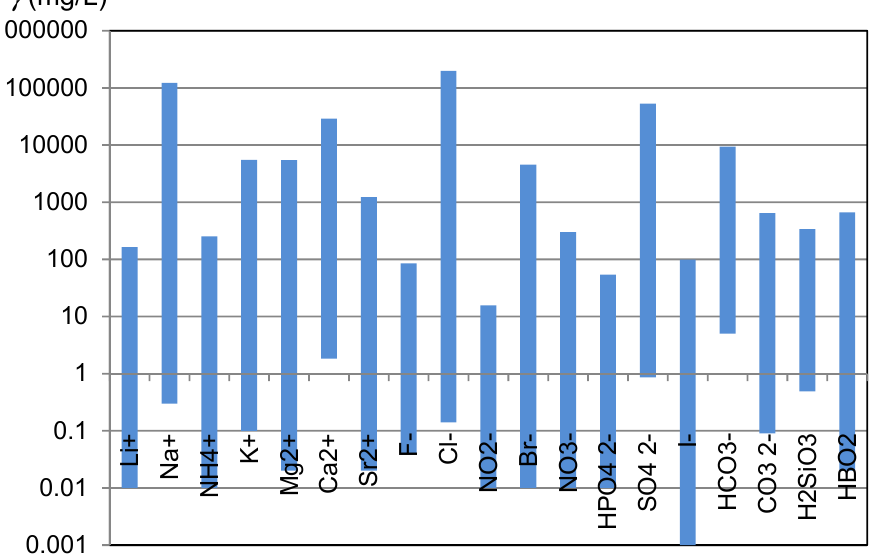
Figure 1. Concentration ranges of ions and other species which are of interest for ion chromatographic analyses and were observed in the Central European mineral and thermal waters